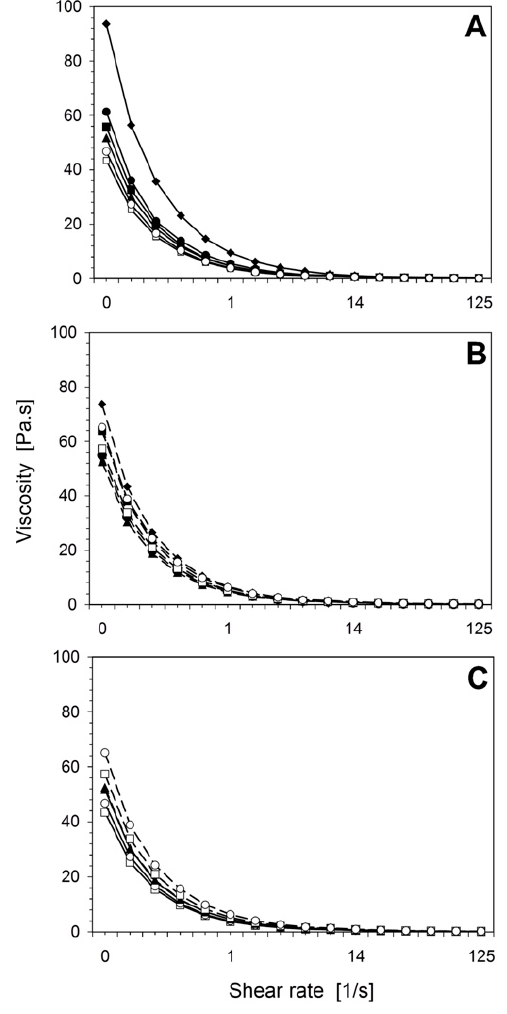
Figure 4. The viscosity of ice cream treatments: Control ( ), T1 ( ), T2 ( ▲ ), T3 ( ● ), T4 ( ), and F5 ( ) for both process designs. Relationship between viscosity and shear rate: ( A ) solid line (—) represents PH, ( B ) dotted line (- - -) represents HP, and ( C ) treatments with only MWPs and eMWPs at a room temperature of 20 ± 2 ◦ C. The product temperature started from 5 ± 2 ◦ C. See Table 1 for the definitions of treatment